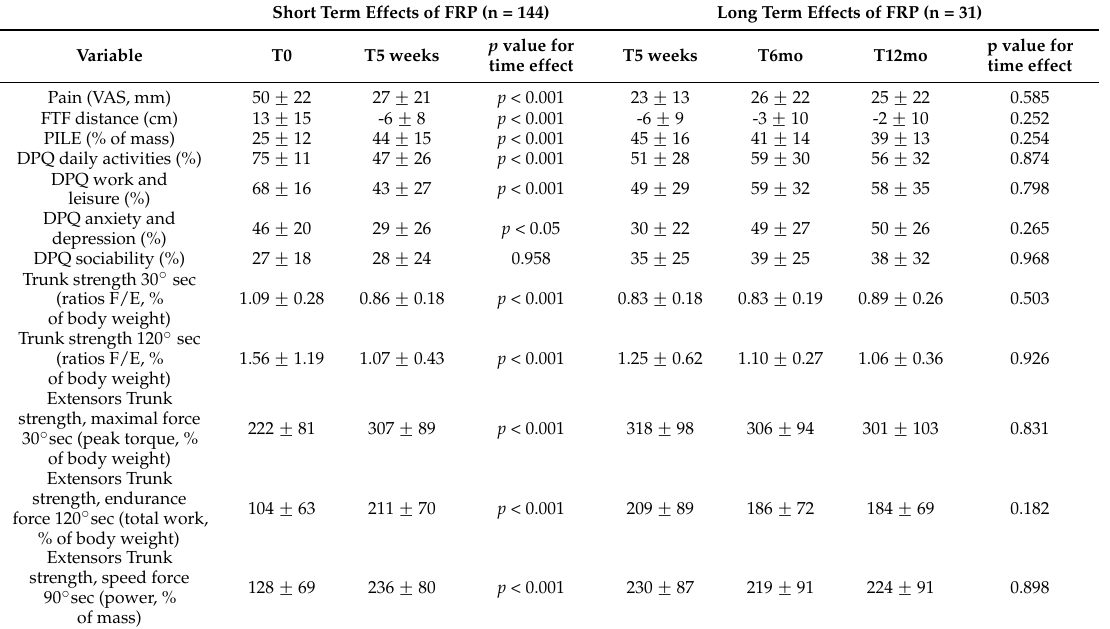
Table 3. Short term (n = 144) and long term (n = 31) effects of the FRP on physical, psychological and occupational measures in CLBP